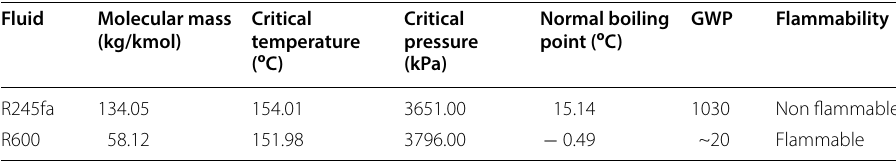
Table 1 Thermophysical properties of the selected pure working fluids Fluid